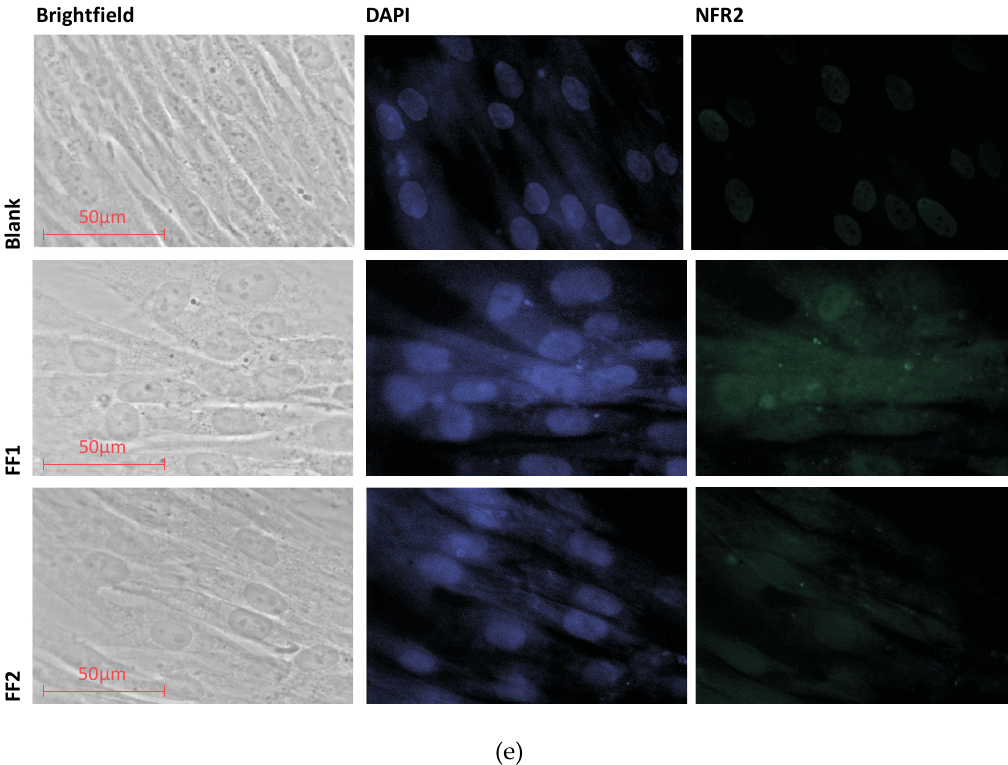
Figure 11. NRF2 protein level in HFLF treated with ( a ) FF1 and ( b ) FF2 in the concentrations shown in figure relative to the blank values (cells were cultured without fullerenes); NRF2 gene expression in HFLF after incubation with ( c ) FF1 and ( d ) FF2 in concentrations shown in figure. NRF2 RNA amount is the average of three experiments in the presence of fullerenes in relation to NRF2 expression in blank. TBP gene was used as the internal reference gene. (*) marks significant di ff erences with blank (cells without fullerenes), p < 0.01, nonparametric U- test; ( e ) fluorescence microscopy, NRF2 antibodies fluorescence in cells treated with FF1 (10 µ M) and FF2 (0.6 µ M); from left to right: transmitted light, DAPI stained nuclei, and the cells were treated with NOX antibodies; from top to bottom: blank and cells after incubation with FF1 (10 µ M) and FF2 (0.6 µ M) for 24 h; magnification, × 40. In blank experiments, cells were incubated without the fullerenes.